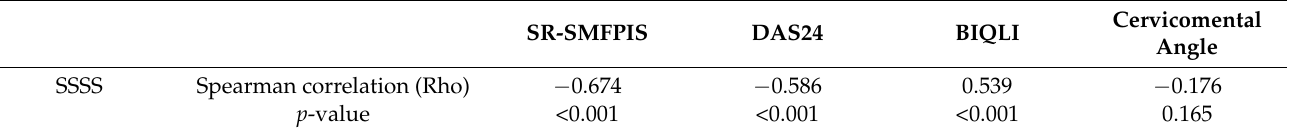
Table 7. Correlation of SSSS with SR-SMFPIS, DAS24, BIQLI, and cervicomental